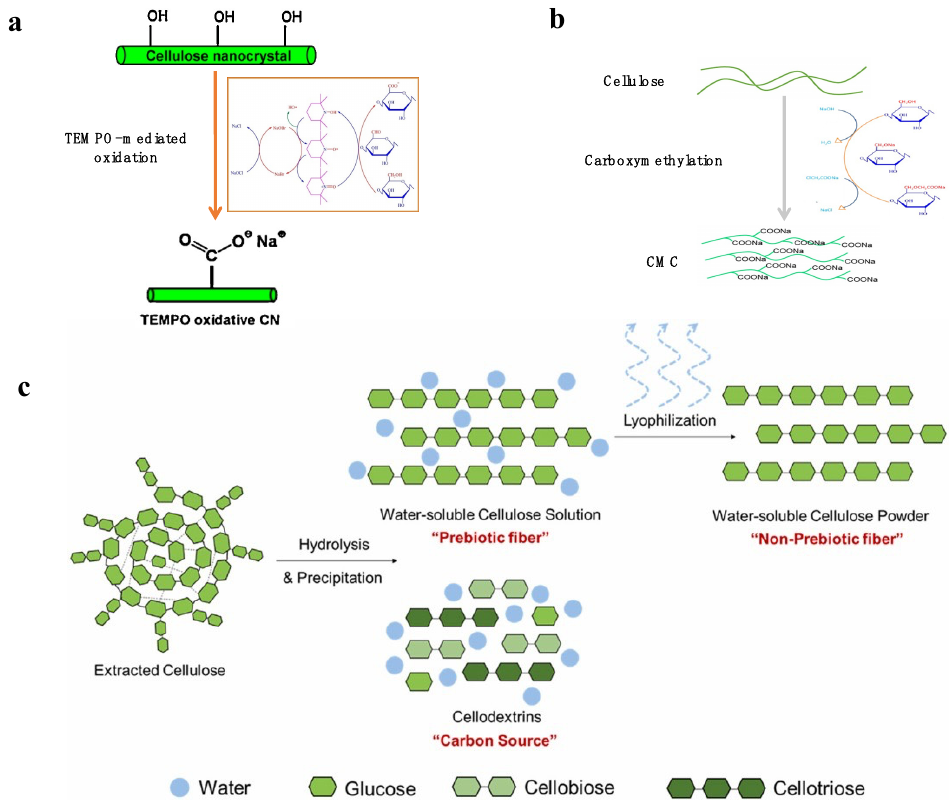
Figure 4. Different pretreatment methods for nanocellulose preparation: ( a ) TEMPO oxidation, reprinted with permission from [69], 2019, Academic Press Inc and [70], 2013, Elsevier; ( b ) carboxymethylation, reprinted with permission from [71], 2022, Elsevier; ( c ) enzymatic hydrolysis, reprinted with permission from [72], 2021, Elsevier.